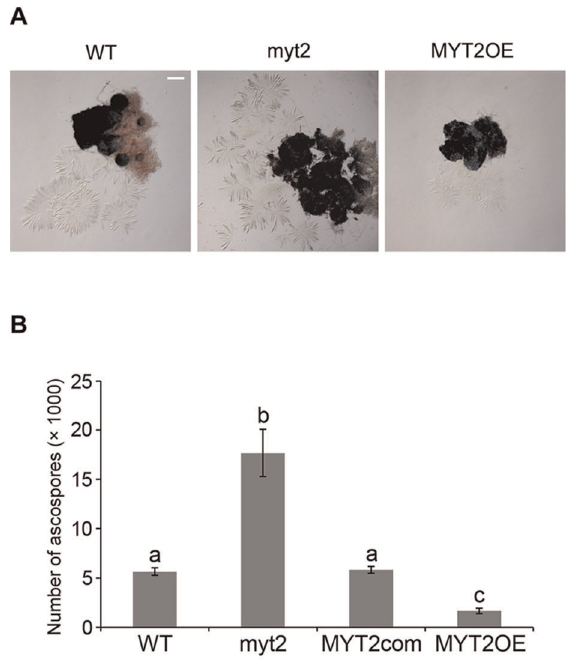
Figure 4. Asci rosettes and ascospores per perithecium of the G.zeae strains. Each strain was inoculated on carrot agar and was mock fertilized. (A) The perithecia from each strain were softly squeezed with cover slides to exude whole asci rosettes. The picture of each strain is representative of more than 20 repetitions. (B) All discharged ascospores were collected from the culture plate through 14 days after sexual induction. The number of ascospores per perithecia was obtained by dividing the number of perithecia by the number of discharged ascospores. Values with different letters are significantly different ( p , 0.05) based on Tukey’s test. WT, G. zeae wild-type strain Z- promoter in place of the MYT2 promoter region.